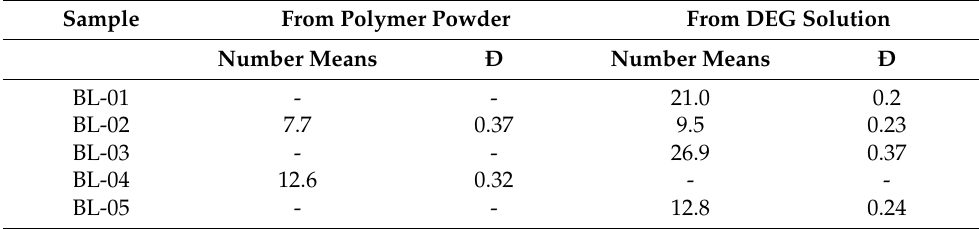
Table 5. Micelle size (Number mean size) of polymers and Ð by DLS. Sample From Polymer